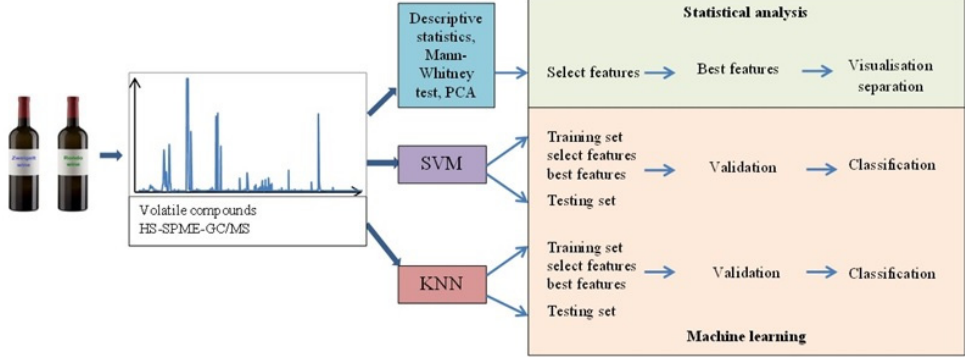
Figure 6. Methodology used for the analysis of Zweigelt and Rondo